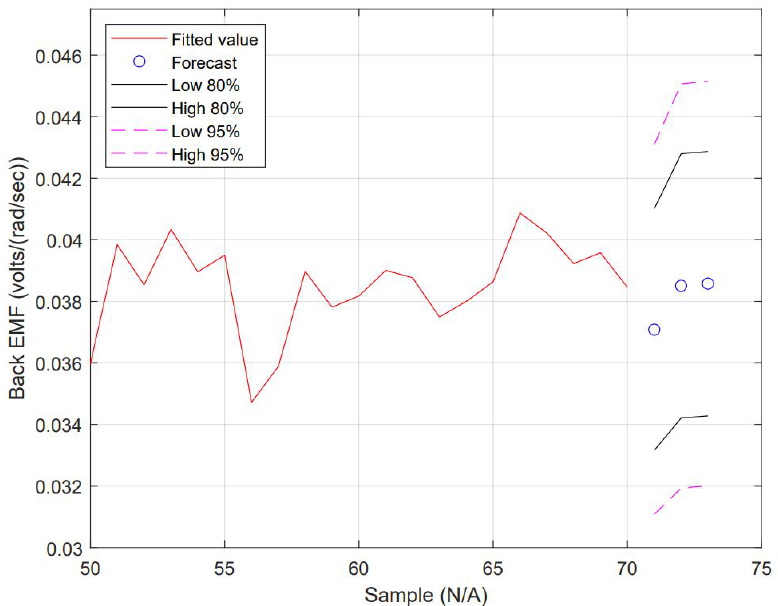
Figure 13. Regression produced with the ARMA model and forecast for the next 3 consecutive values (blue dots shown with